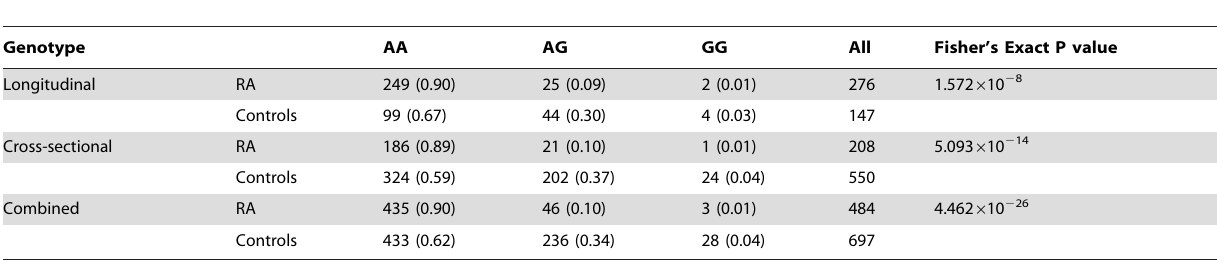
Table 2. Association with rheumatoid arthritis at rs231778 in African Americans.